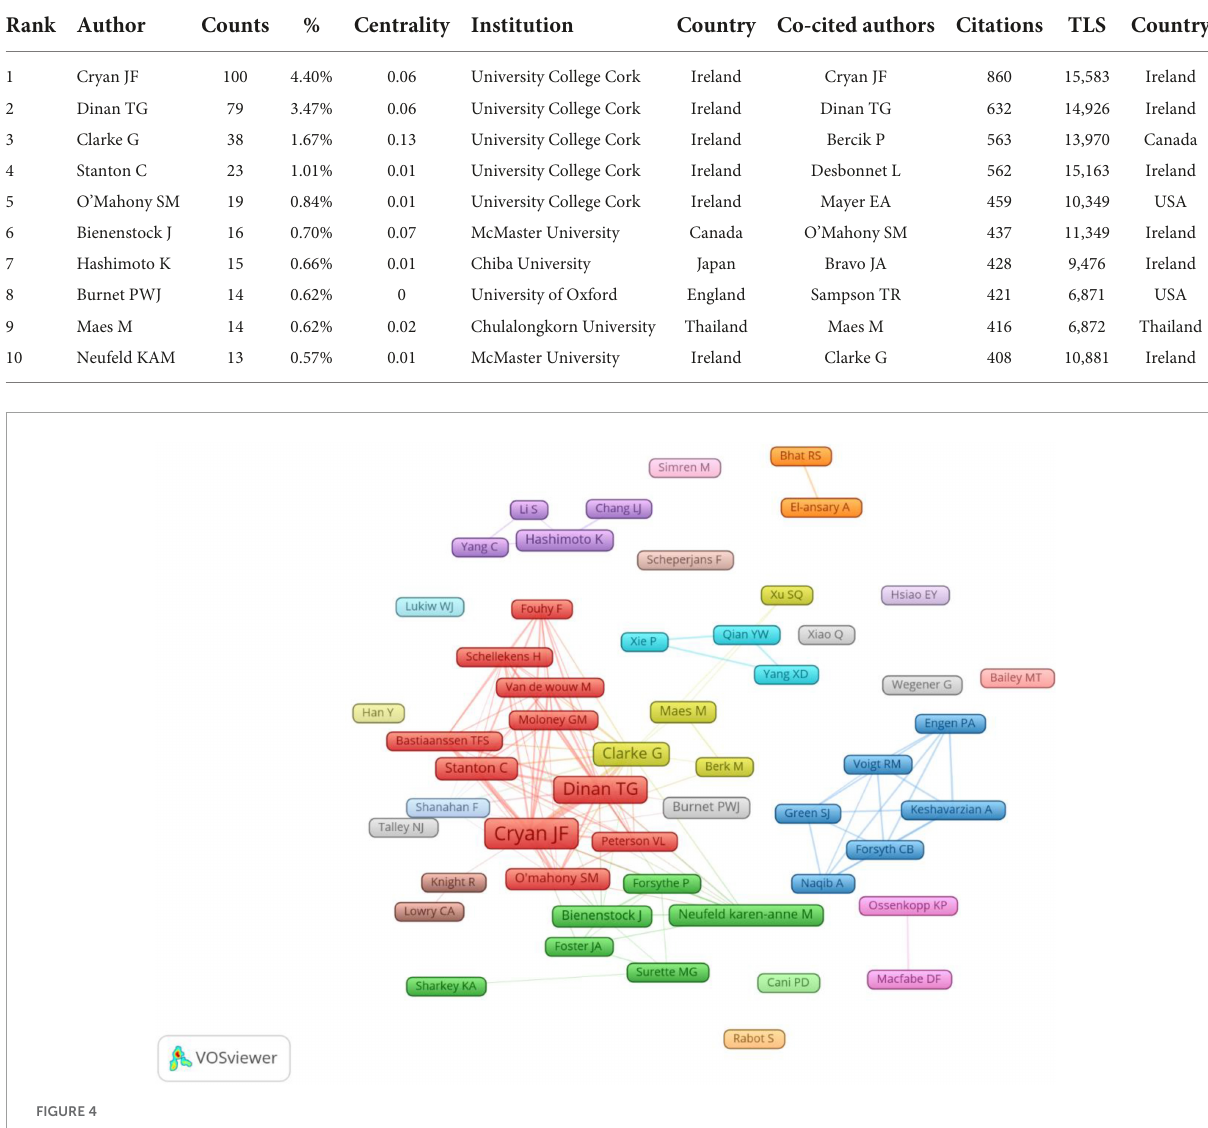
TABLE 3 Top 10 productive and most co-cited authors on gastrointestinal microbiome and neuroscience research.